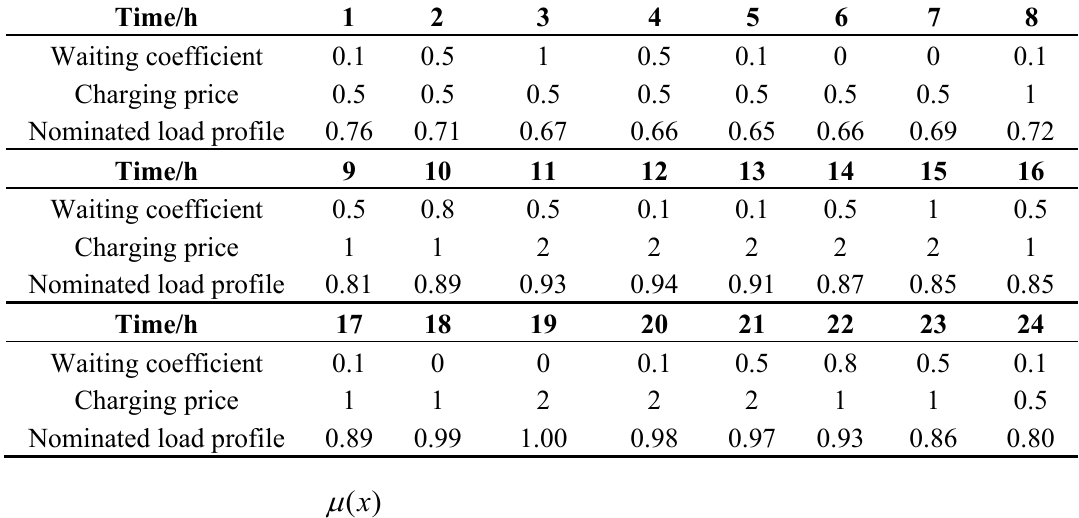
Table 1. Case setting of charging period.